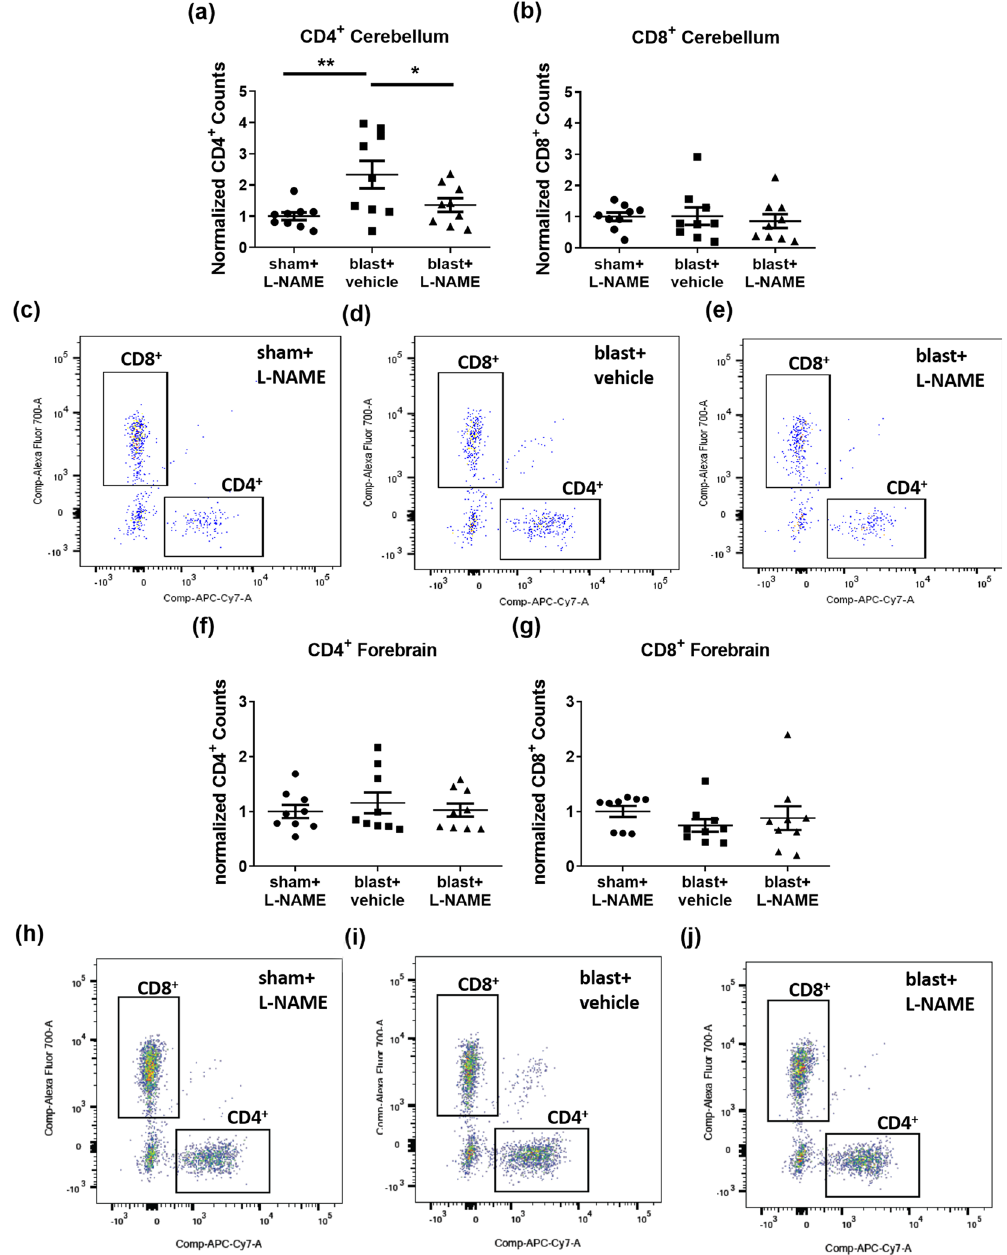
Figure 4. Nitric oxide inhibition attenuates CD4 + T-cell infiltration in the cerebellum following repetitive blast. (a) Flow cytometry revealed that repetitive TBI significantly increased CD4 + counts in the cerebellum ( ** p ≤ 0.01), which was significantly attenuated by L-NAME administration ( * p ≤ 0.05). (b) No differences were measured in cerebellar CD8 + counts after repetitive TBI ( p > 0.05). (c) Scatter plots for cerebellum of shams, (d) blast vehicle-treated, and (e) blast L-NAME-treated mice. (f) No differences in CD4 + counts ( p > 0.05), or (g) CD8 + counts were measured in forebrain after repetitive mTBI ( p > 0.05). (h) Scatter p lots for forebrain of shams, (i) blast + vehicle-treated, and (j) blast + L-NAME-treated mice. One-way ANOVA post- hoc Newman-Keuls. Values represent means ±